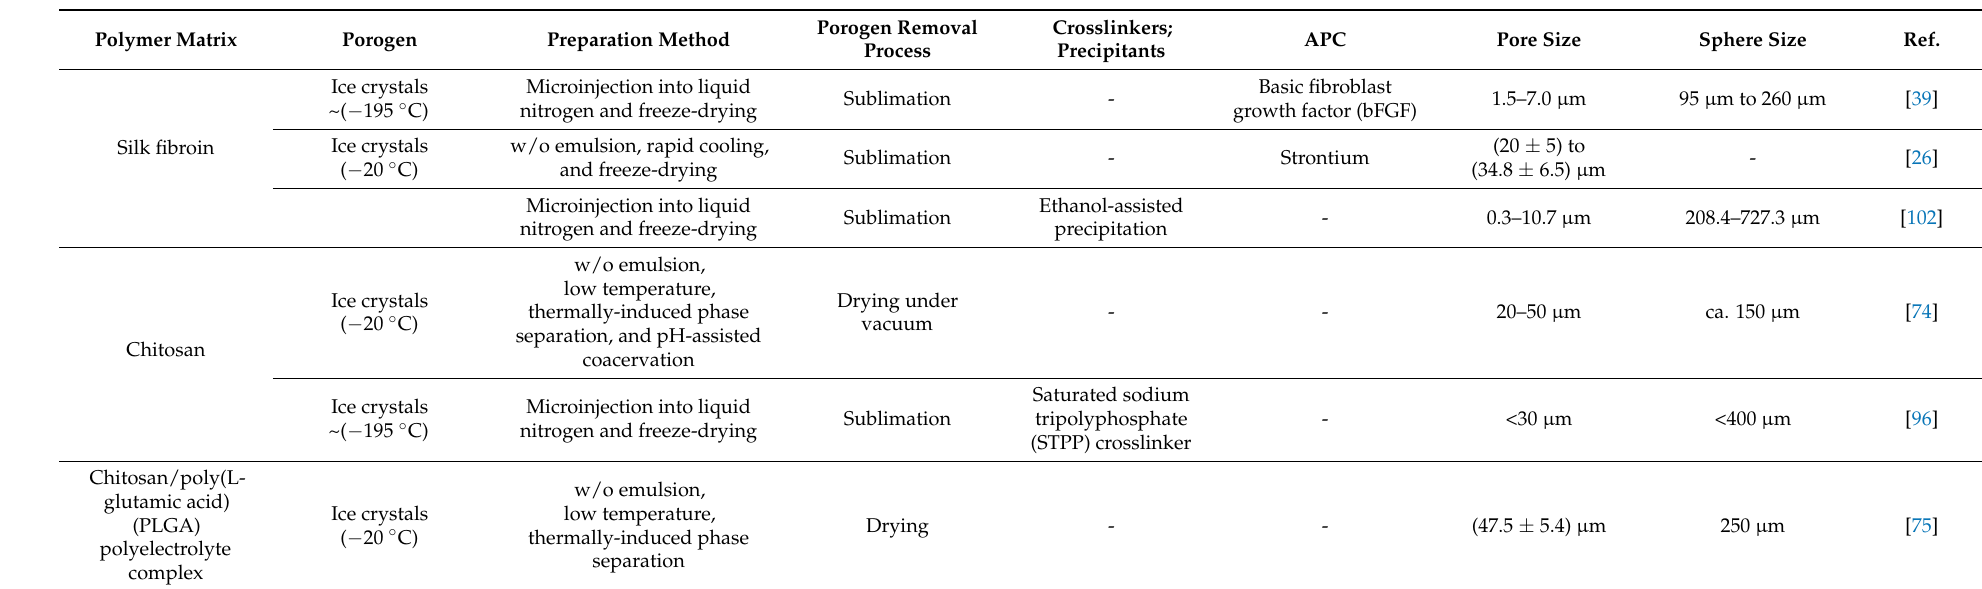
Table 3. Examples of porous spheres prepared by solid & emulsion templating